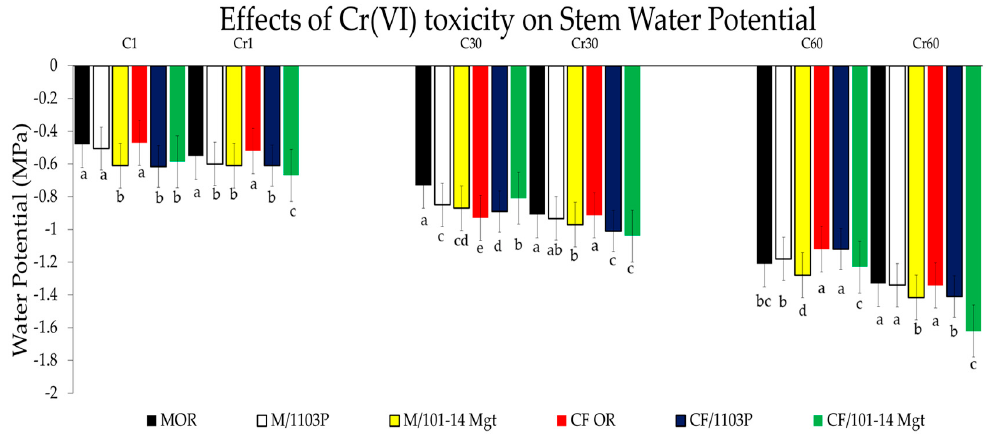
Figure 5. Chromium(VI) toxicity effects on midday stem water potential of Merlot (M) and Cabernet Franc (CF) grapevine cultivars on their own roots (OR) and on 1103P and 101-14 Mgt rootstocks at three stages. C: control; Cr: Cr(VI) treatment; 1, 30, 60 (at days one, thirty, and sixty, respectively). F: 85.711. Different letters represent significant difference of p < 0.05.